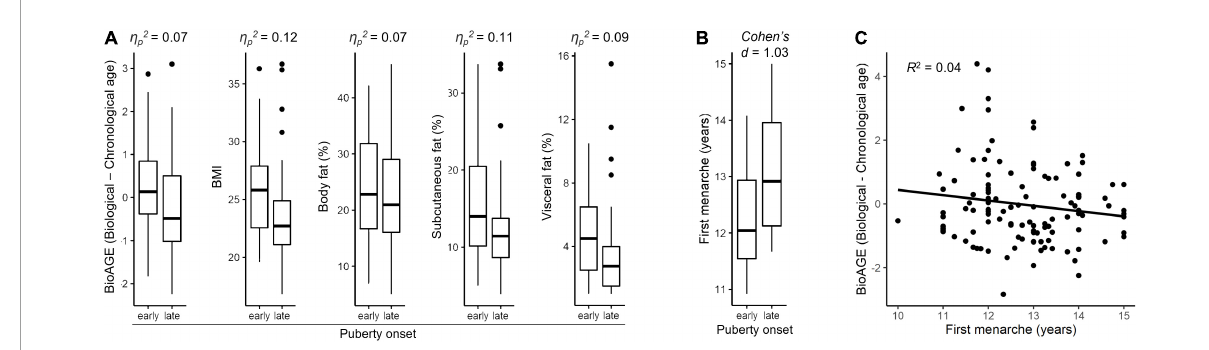
FIGURE3 Pubertal timing. Differences between early and late onset of puberty based on secondary sexual characteristics in relation to accelerated biological aging, BMI, and fat measures in late 20s within whole sample (A) and in relation to age of first menarche in women (B) . Accelerated biological aging (BioAGE) in women predicted by earlier age of first menarche (C) .